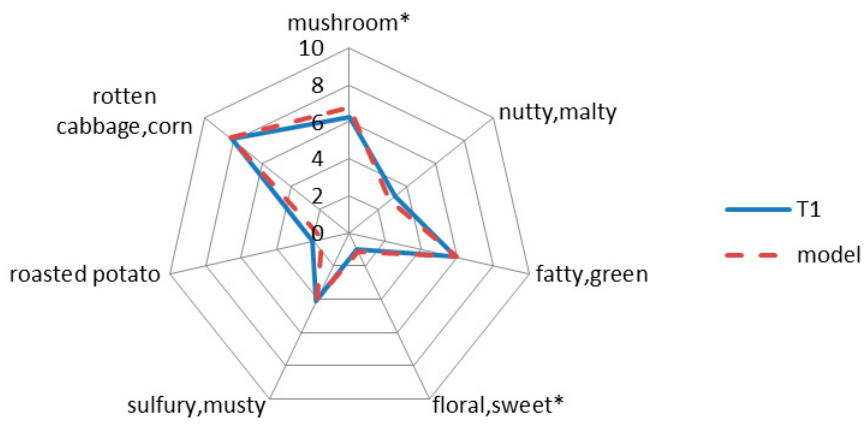
Figure 3. Comparative aroma profiles of T1sample and the aroma recombination model. The seven descriptors with “*” are significantly different between T1 and model. ( p < 0.05).